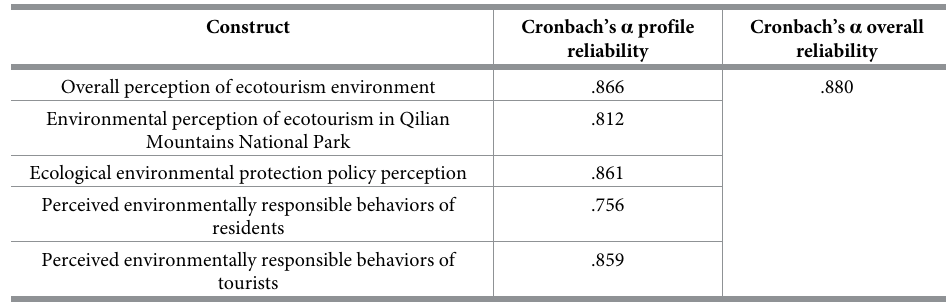
Table 5. Reliability of residents’